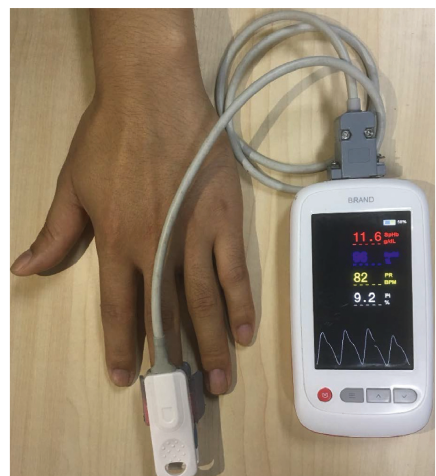
Figure 2: Prototype of the portable noninvasive Hb monitoring